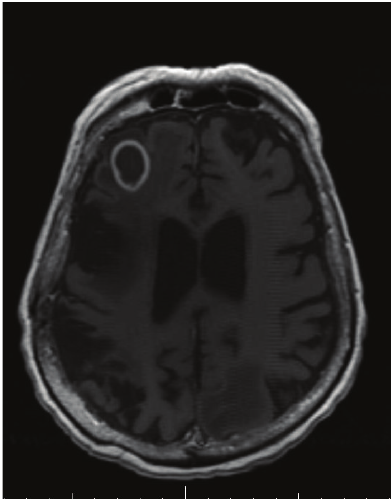
Figure 5: Magnetic resonance imaging of the brain showing ring enhancing lesion in the right frontal lobe, one month after initial presentation.